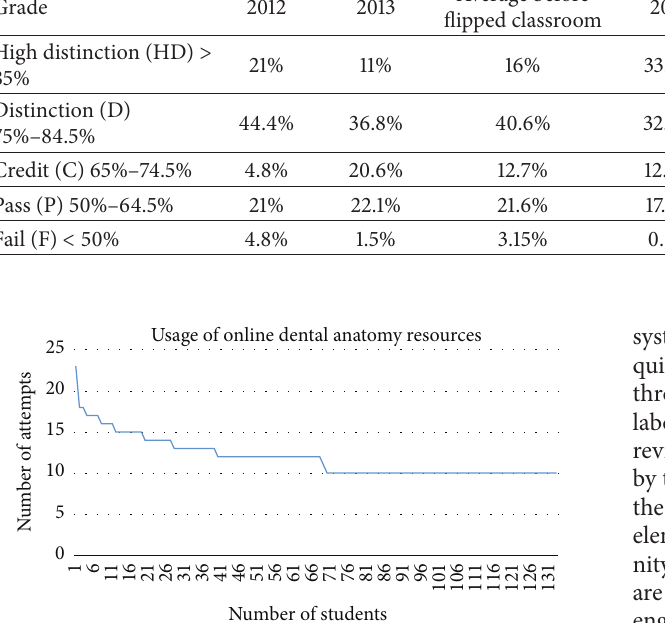
Figure 3: A summary of the students’ usage of the online dental anatomyresourcesinvestigatedinthisstudy.Thenumberofstudents is shown on 𝑥 -axis and the number of attempts is shown on 𝑦